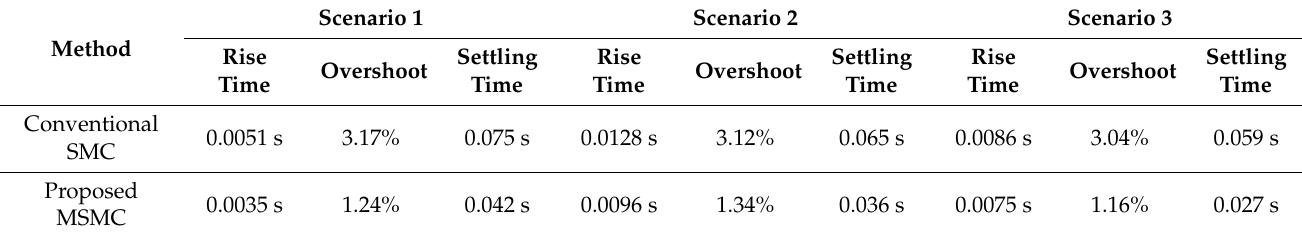
Table 3. Performance comparison of studied method for active power.